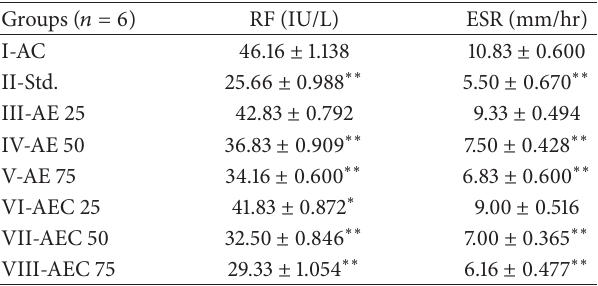
Table 6: Effect of AE and AEC on RF and ESR levels in Freund’s complete adjuvant induced arthritic